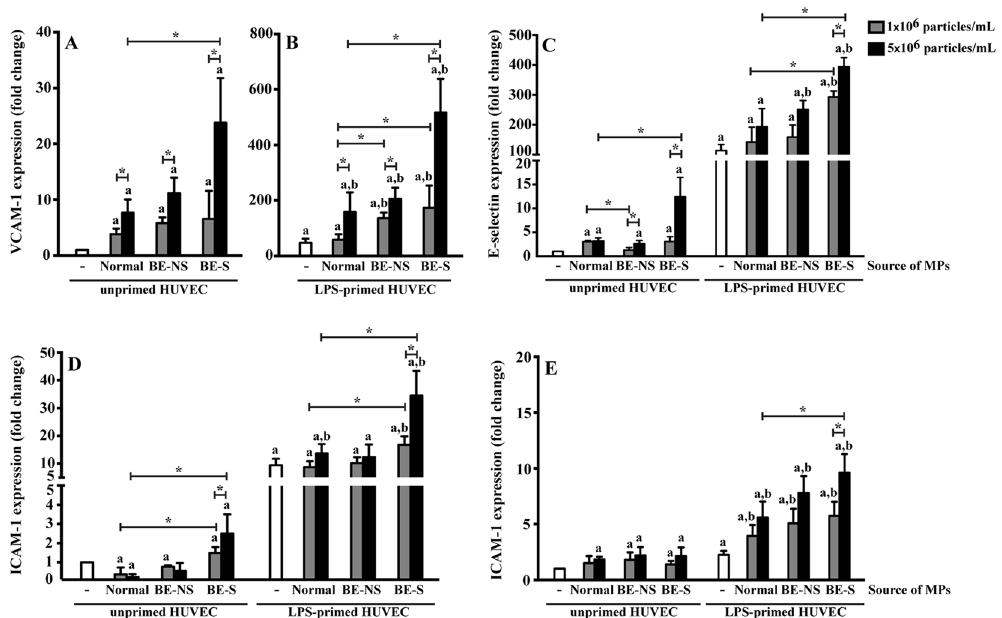
Figure 4. MPs induced adhesion molecule expression. Unprimed and LPS-primed HUVECs were treated with 1 × 10 6 and 5 × 10 6 particles/mL MPs obtained from 7 normal subjects, 9 non-splenectomised β -thalassaemia/ HbE patients (BE-NS) and 9 splenectomised β -thalassaemia/HbE patients (BE-S). HUVECs were analysed for the expression of ( A , B ) VCAM-1 mRNA, ( C ) E-selectin mRNA and ( D ) ICAM-1 mRNA using RT- qPCR. ( E ) Flow cytometric analysis of ICAM-1 expression on HUVECs were also performed. a Statistically significant difference when compared with unprimed HUVECs at P < 0.05. b Statistically significant difference when compared with LPS-primed HUVECs at P < 0.05. * Statistically significant difference between groups at P < 0.05. Each experiment was